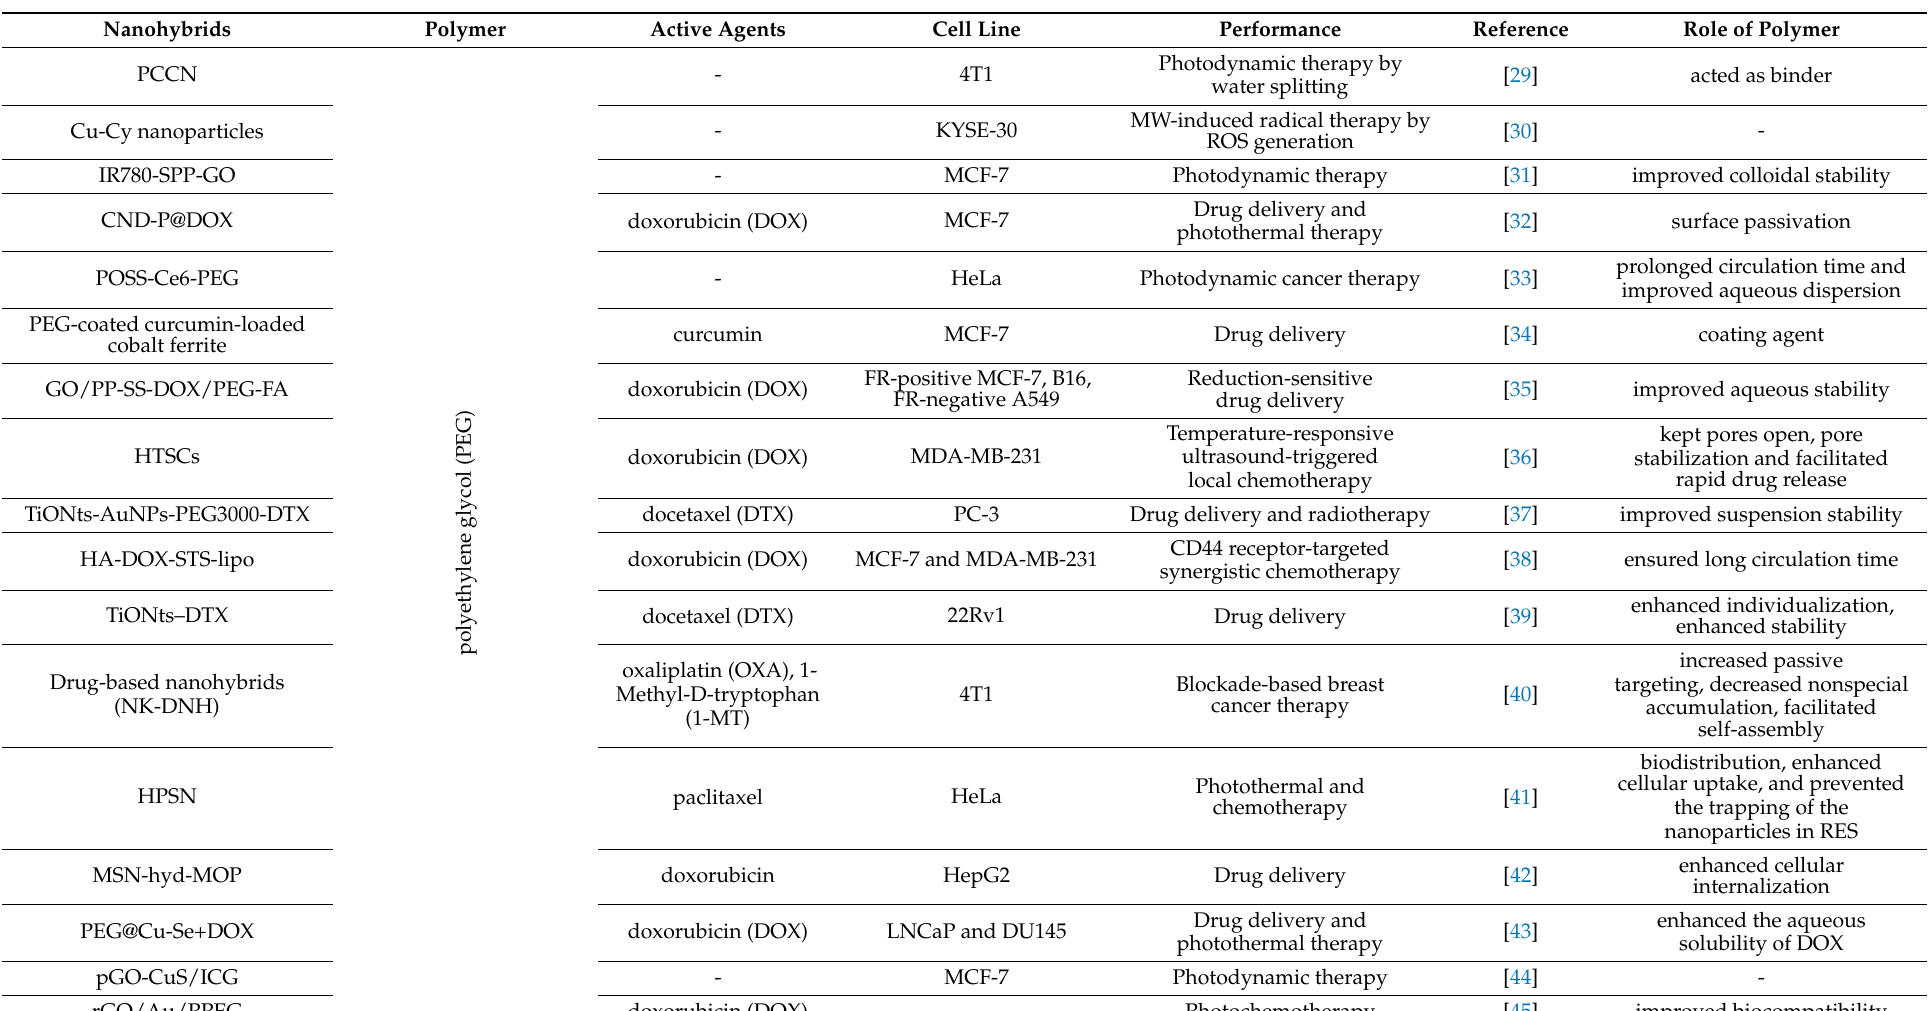
Table 1. List of polymeric nanohybrids synthesized in recent years and their